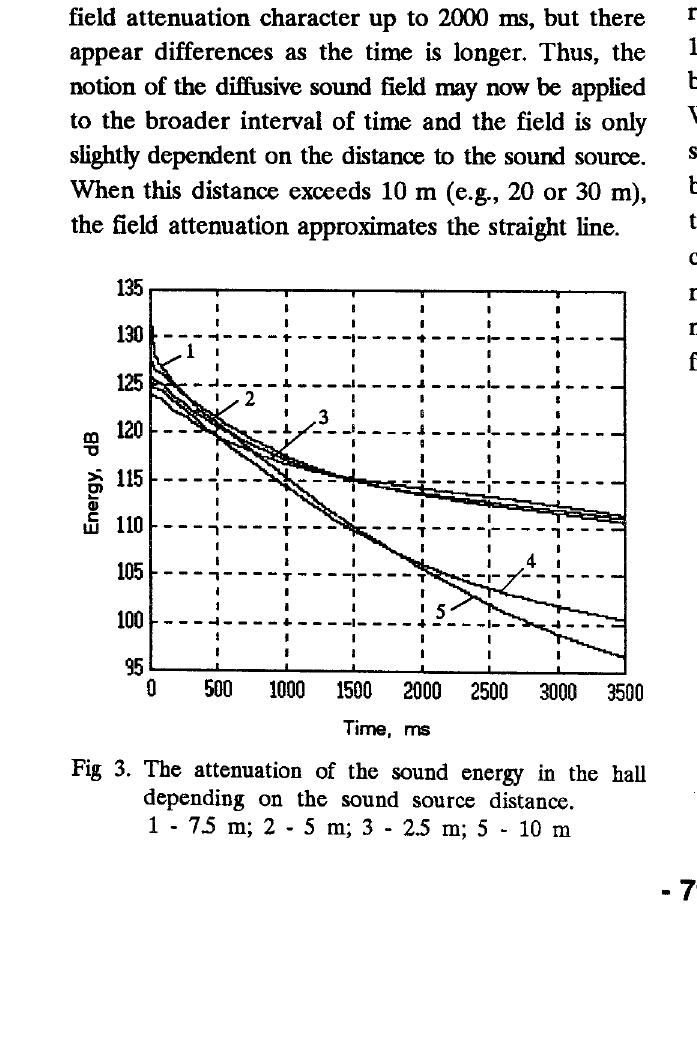
Fig 3. The attenuation of the sound energy in the hall depending on the sound source distance.